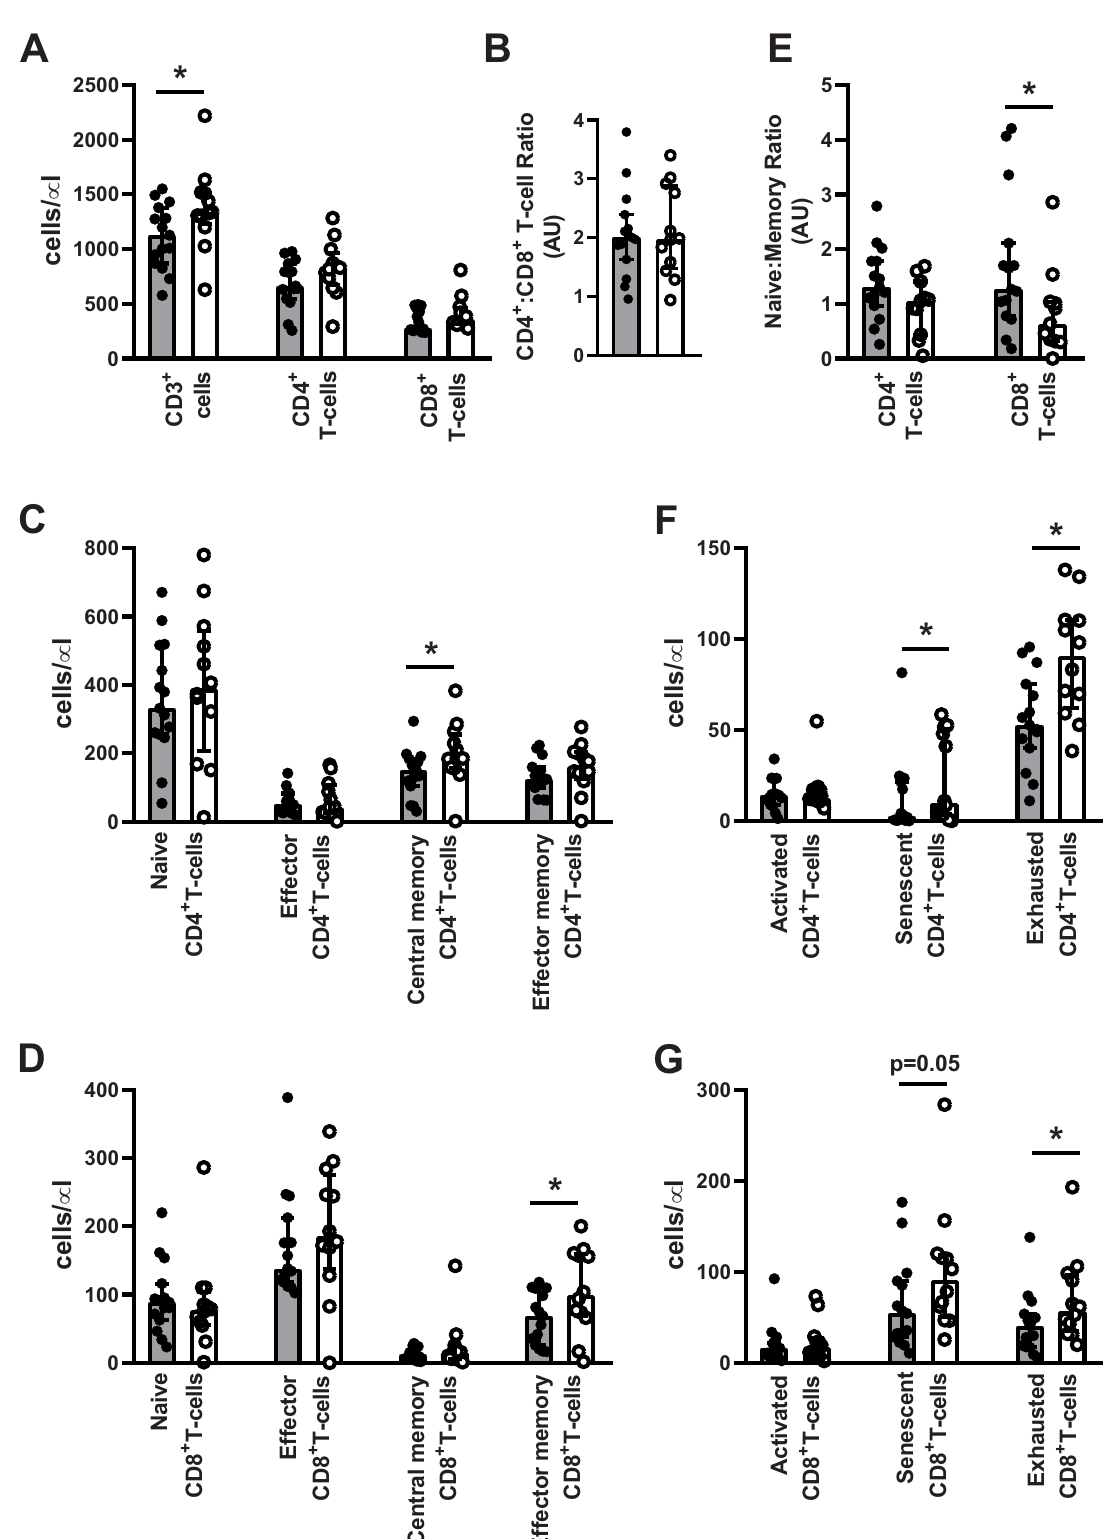
Fig 1. T-cell subsets in pre-and postmenopausal women. Premenopausal (n = 15, grey bars and black dots) and postmenopausal (n = 12, white bars and white dots) women. (A) CD3+ lymphocytes, CD4+ T-cells, and CD8+ T-cells. (B) CD4+:CD8+ T-cell ratio.